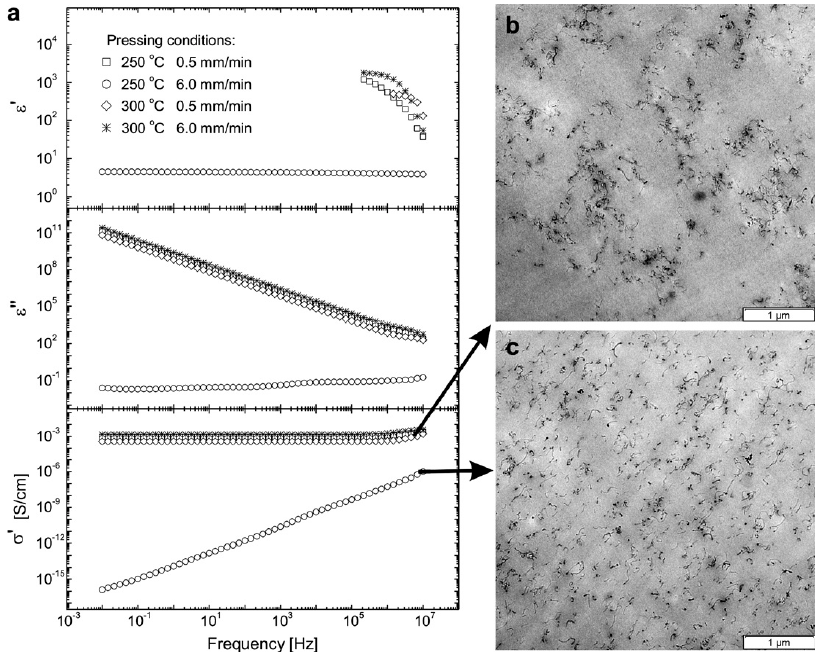
Figure 18. Variation of conductivity with frequency for compression molded polycarbonate/MWCNT plates (0.6 vol% MWCNT) and related TEM micrographs. ( a ) real ( ε ’) and imaginary ( ε ”) permittivity and AC conductivity ( σ ’) plotted vs frequency; ( b ) TEM micrographs of samples pressed at 300 ◦ C; ( c ) and 250 ◦ C